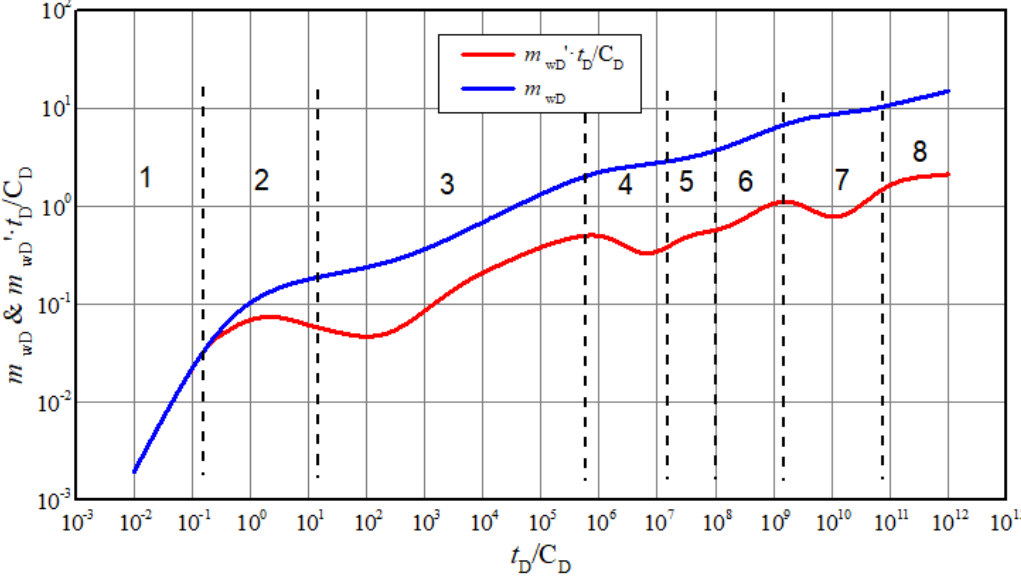
Figure 3. Typical log-log curves of highly deviated well in composite carbonate gas reservoir. Wellbore storage period. The pseudo-pressure and pseudo-pressure derivative are straight lines ◦ with 45